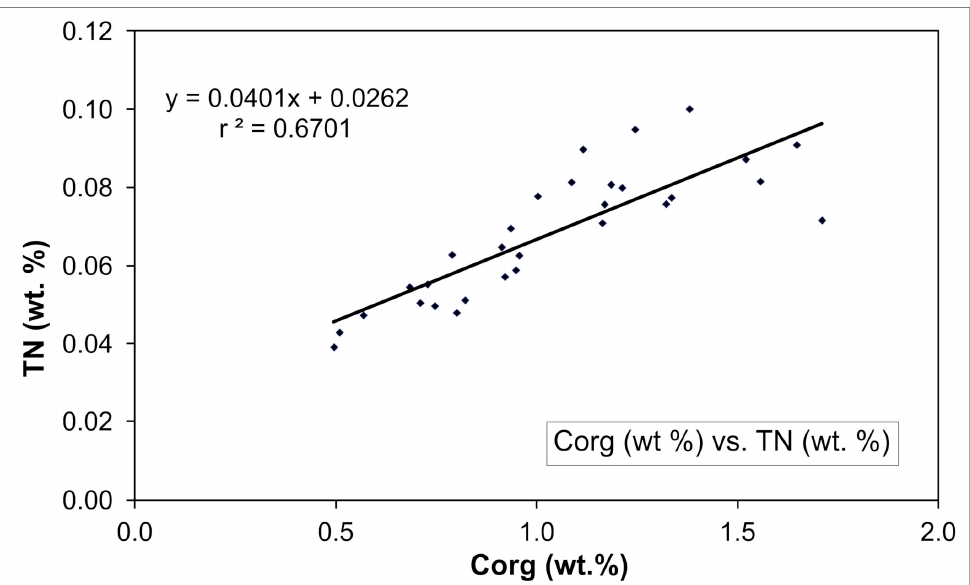
Figure 5. Plot of Organic Carbon (C org ) versus Total Nitrogen (TN) for bulk sediment samples. A positive correlation exists between the two parameters, modeled by a linear regression (r 2 = 0. 7).